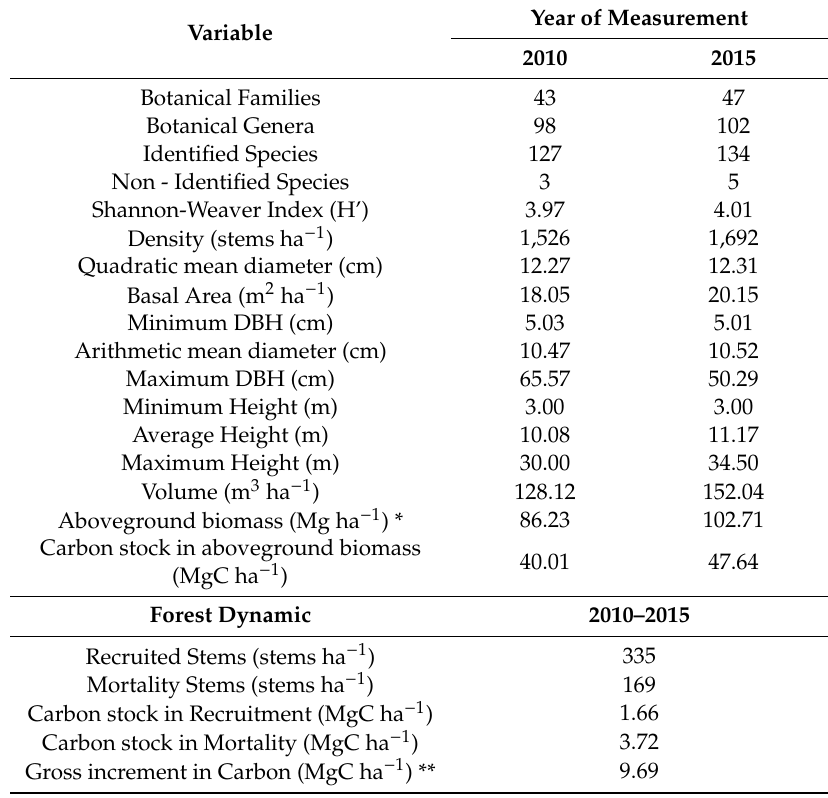
Table 1. Phytosociological parameters, floristic composition, and forest dynamic of the secondary Atlantic Forest